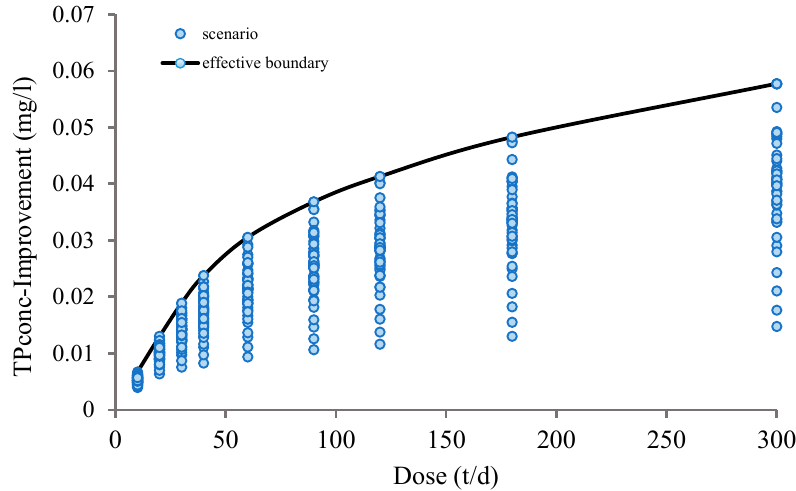
Figure 14. Response and effective boundary for 1944 scenarios (average for simulation period and seasons). Table 4. Result of cost-effective analysis for each dose level.